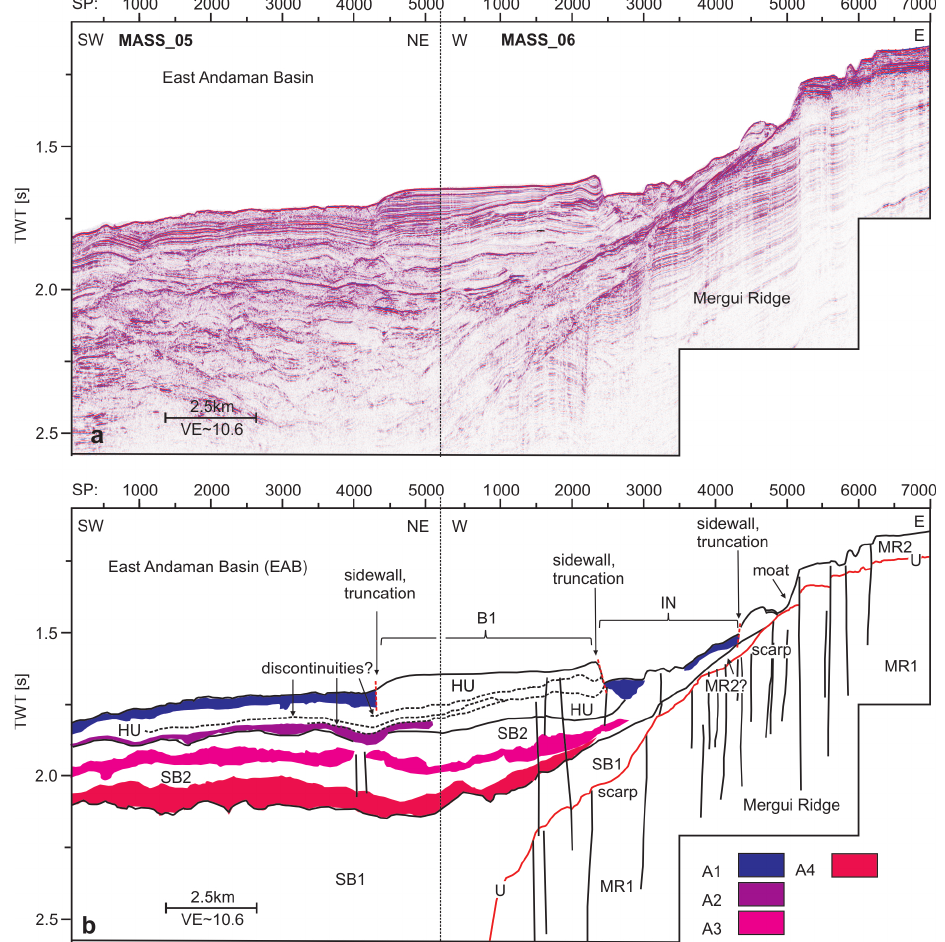
Fig. 5. (a) Seismic profiles MASS 05 and MASS 06, from the southern working area. (b) Interpretation of the profile, showing Mergui Ridge seismic units MR1 and MR2 in the east and basin sedimentary units SB1, SB2 and HU in the SE. The black lines mark boundaries of seismic units. The red line denotes the position of unconformity U . The vertical lines mark the positions of faults. The colored areas denote the position of MTDs within the basin sediments. The black dashed line marks discontinuities within the upper unit HU, indicative of drift deposits. B1 marks a stable block/slide margin, confined by steep sidewalls, and bordered by disturbed sediment bodies of superficial deposit MTD A1; “IN” indicates an incision in the sedimentary column. See Figs. 2 and 3 for the location of the profiles and text for further